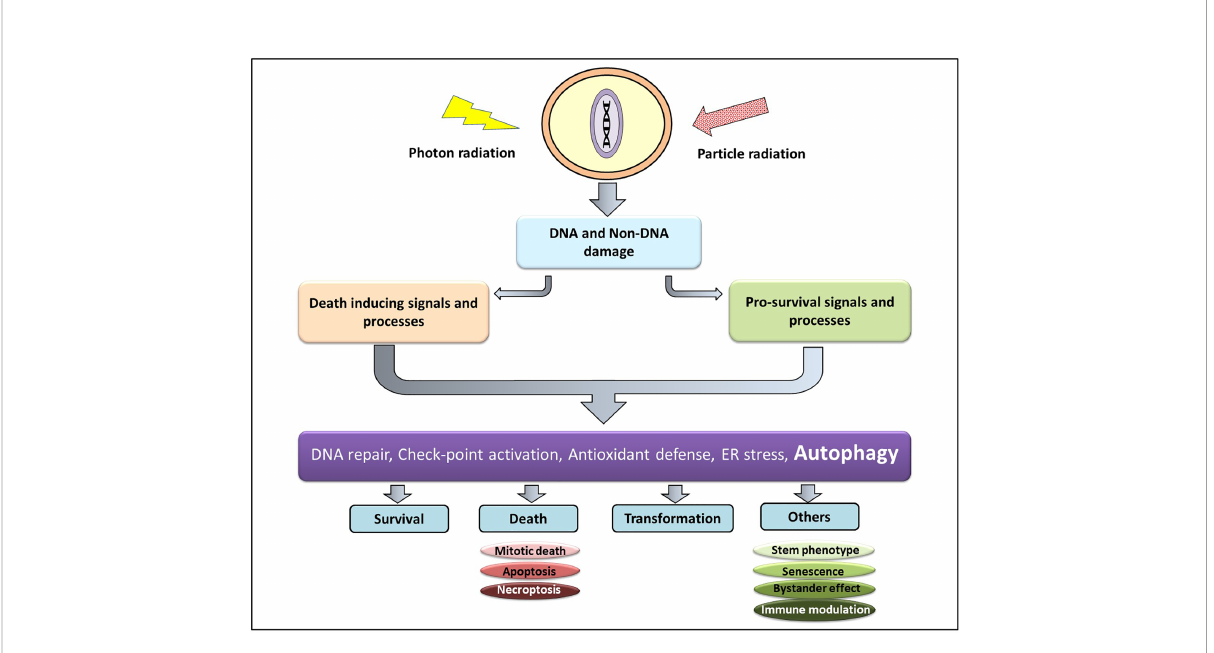
FIGURE 1 Cellular responses to radiation damage. Radiation induced macromolecular damage (DNA and non-DNA) activates pro-survival and death processes regulated by several proteins (ATM, p53, ATF6, Atg, NF kb etc) whose level and activity are regulated majorly by post-translational modi fi cations (which can be targeted for therapeutic bene fi t). This results in survival, death, and transformation of the irradiated cells, besides other